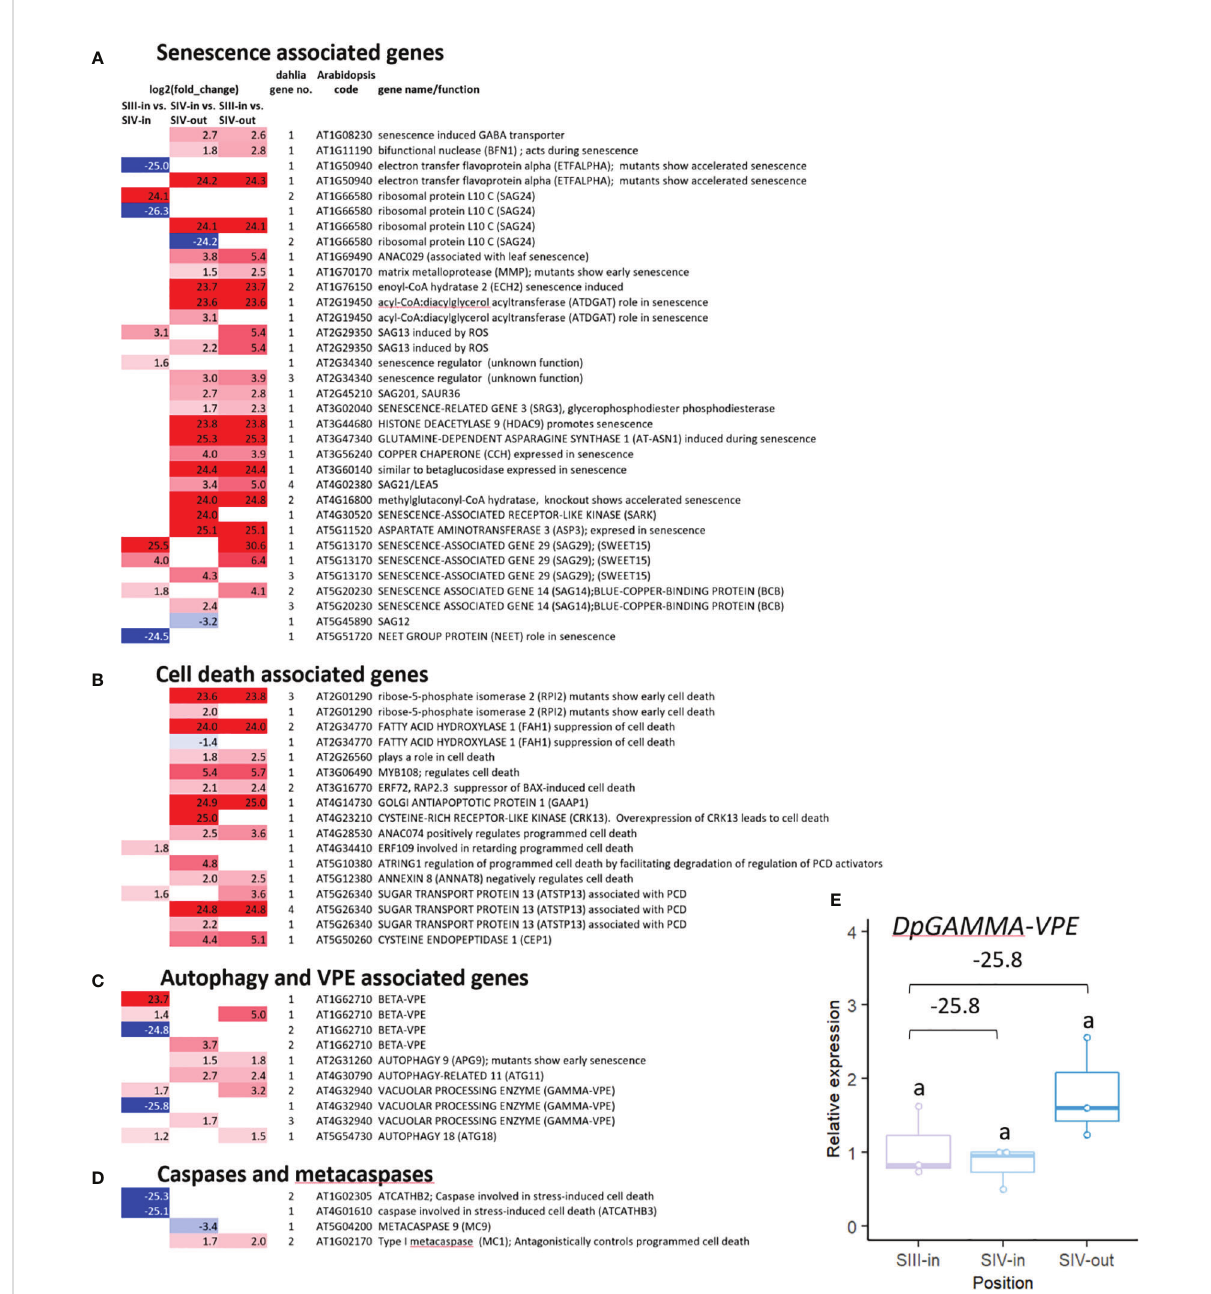
FIGURE 4 Transcriptome DEGs associated with (A) senescence (B) cell death (C) autophagy and vacuolar processing enzymes (VPEs), (D) caspases and metacaspases. Red to blue scale shows Log 2 fold change ( p. adjust < 0.05); based on annotation to Arabidopsis thaliana; inner fl orets of Stage III fl owers (III-in), inner fl orets of Stage IV fl owers (IV-i) and outer fl orets of Stage IV fl owers (IV-out); gene no. indicates number of dahlia genes with homology to each Arabidopsis gene with similar expression pattern. (E) RT-qPCR of Dp g -VPE expression, n=3, different letters indicate signi fi cant differences p < 0.05, based on a 2-way ANOVA followed by a Tukey ’ s test or a Kruskall Wallis test followed by a Dunn ’ s post hoc test if the data did not fi t the normality and equal variance criteria required. RNA seq log2FC shown on